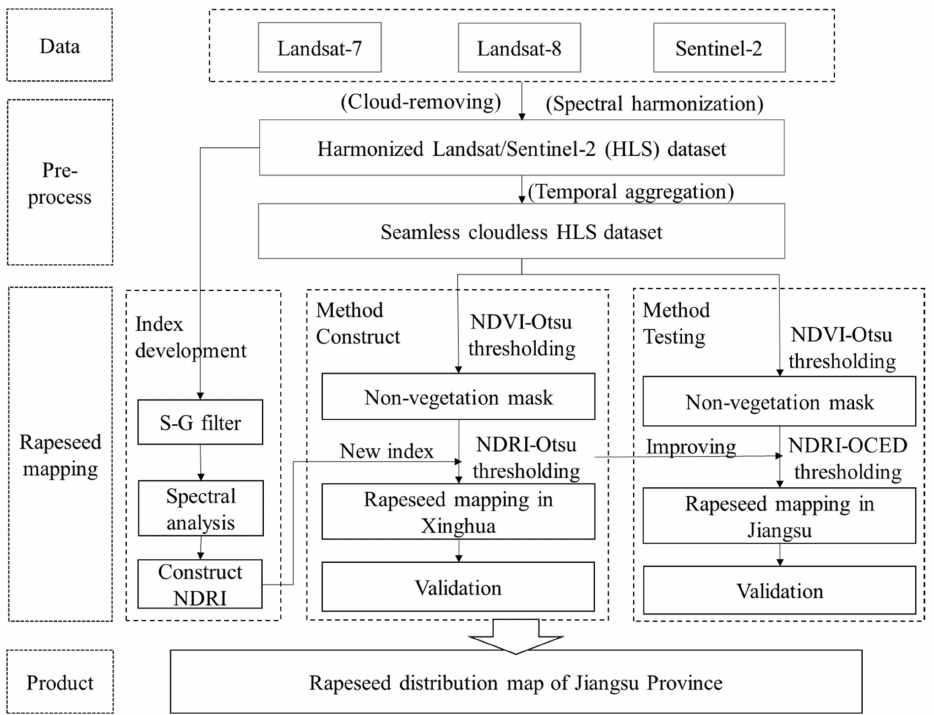
Figure 3. Workflow of two-stepwise hierarchical adaptive thresholding (THAT) rapeseed mapping